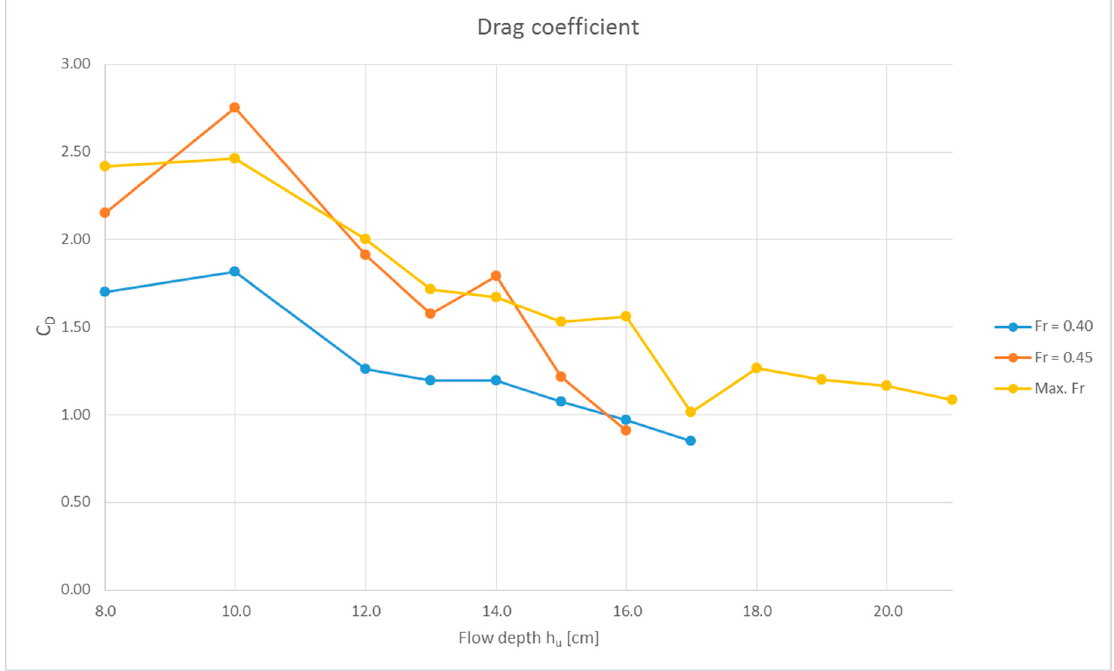
Figure 12. Pier drag coefficients. It can be seen that the values approach the canonical value of 0.7 [14] as the flow depth, h u , keeps increasing. However, blockage and free surface effects are clearly visible at low flow depths where the pier is not fully submerged.